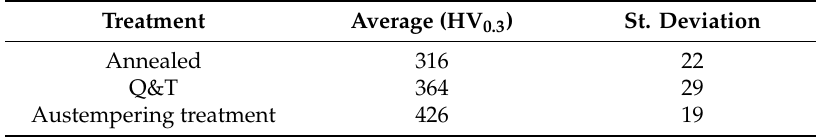
Table 4. Microhardness on material before tensile